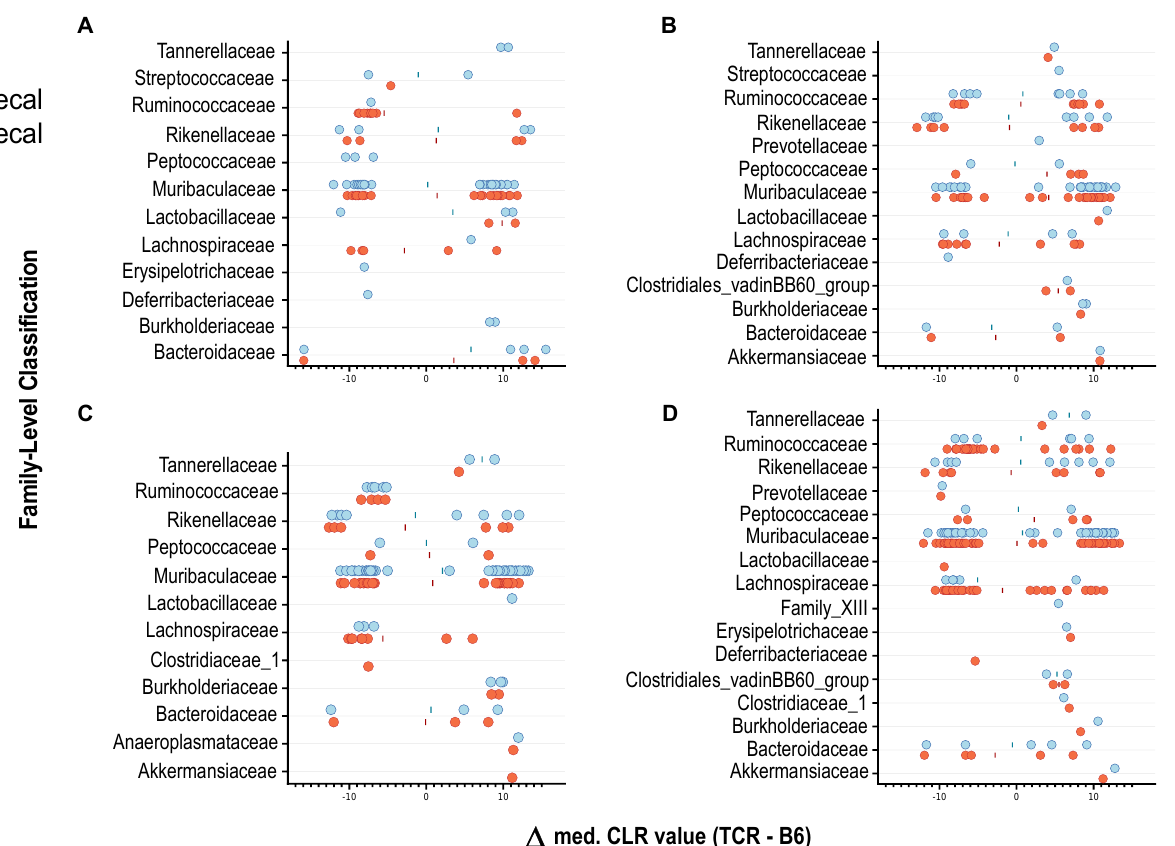
Figure 2. Differentially abundant taxa between C57Bl/6 (B6) and T cell receptor double knock out ( TCR β– / –δ– / – ) mice. Individual graphs represent results at ( A ) P17, ( B ) P24, ( C ) P28, and ( D ) 12 weeks. Each circle represents an individual ASV that was significantly increased or decreased between genotypes, with the median difference in CLR-transformed relative abundance plotted on the X-axis. Positive values represent taxa that are significantly more abundant in TCR β– / –δ– / – mice compared to B6 controls, whereas negative values represent those significantly more abundant in B6 mice.